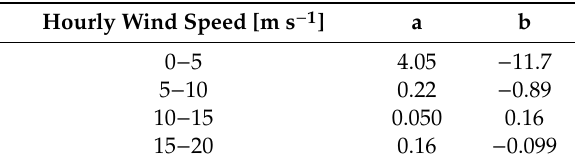
Table 1. The parameters of the empirical equations yielding the proportions of sea spray at various rainfall intensities for di ff erent hourly wind